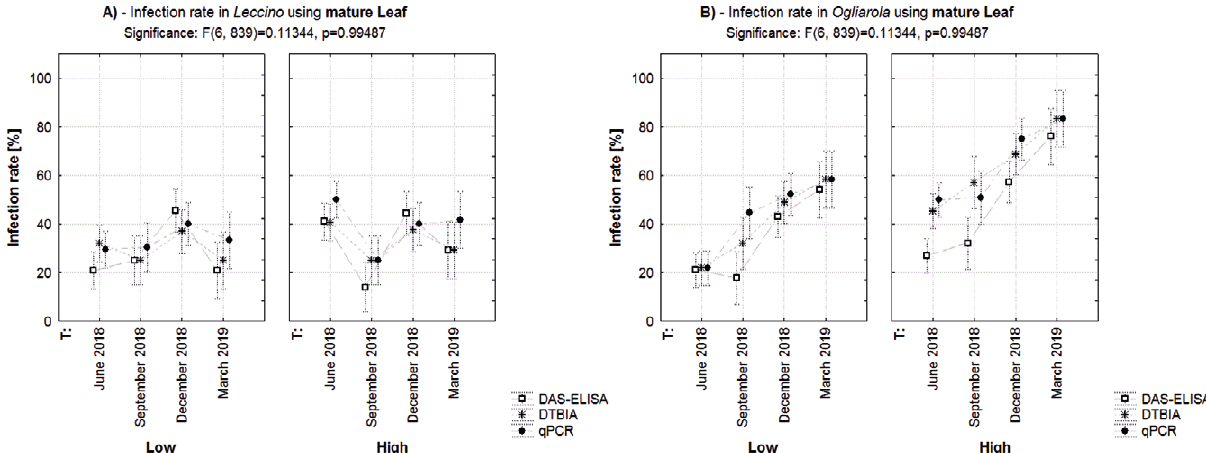
Figure 5. Mean Xylella fastidiosa infection rates in ‘Leccino’ (A) and ‘Ogliarola salentina’ (B) olive trees assessed using the host leaves, and three diagnostic assays at four diff erent sampling times (T).